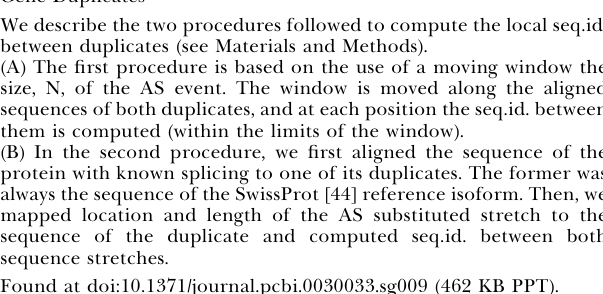
Figure S9. Computation of the Local Sequence Identity Between Gene Duplicates